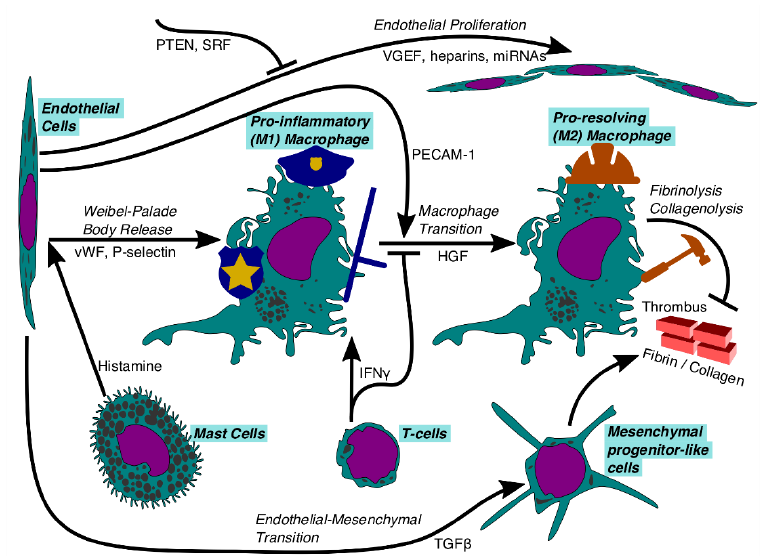
Figure 3. Global mechanism of thrombus resolution via some of the immune system cells. The top row of cells are ambivalent or beneficial to DVT resolution, whereas the bottom row of cells impede DVT resolution. Endothelial cells can either aid in thrombus resolution by proliferating to seal o ff the developing thrombus, or transition into mesenchymal progenitor-like cells, which slow thrombus resolution by depositing more collagen. Both mast cells and T-cells trigger the activation of pro-inflammatory macrophages, with mast cells potentially using endothelial cells as intermediaries. T-cells secrete interferon gamma (IFN γ ) which locks macrophages into the pro-inflammatory phenotype. However, with PECAM-1 from endothelial cells or hepatocyte growth factor (HGF), pro-inflammatory macrophages transition to become pro-resolving, at which point they promote fibrinolysis and